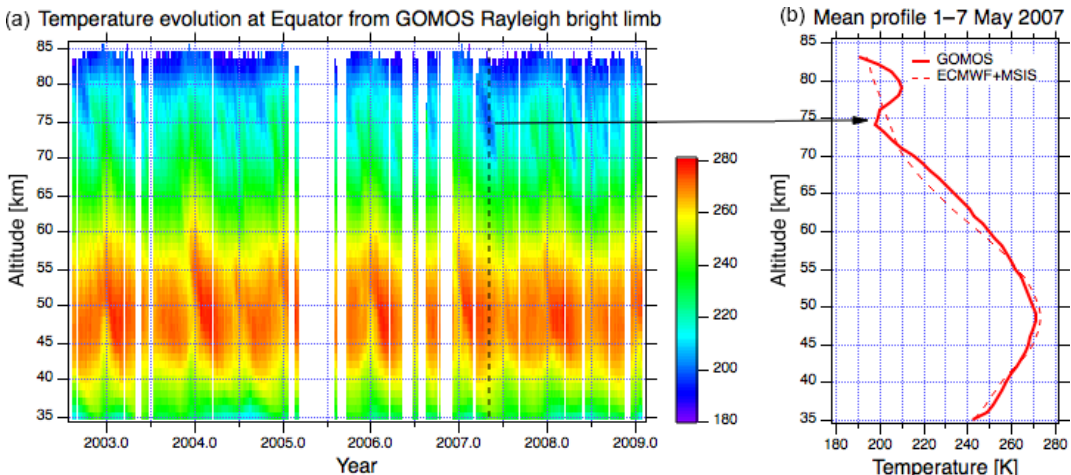
Figure 9. (a) Evolution of the weekly averaged temperature profile at the Equator obtained using all occultations of the polar star with a tangent point latitude always situated in the interval 0.8 ◦ S–0.8 ◦ N. (b) Vertical weekly mean profile at the beginning of May compared to the GOMOS external model.